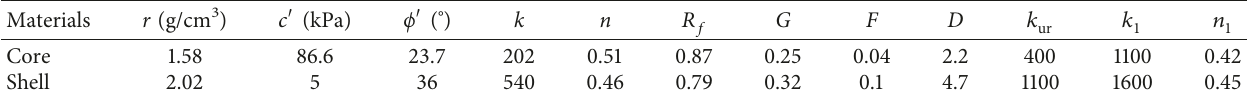
Table 3: Parameters of the E - μ model and equivalent linear model.